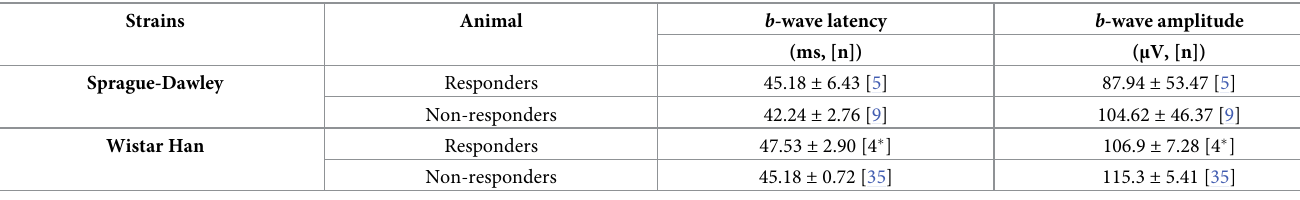
Values are mean ± SD